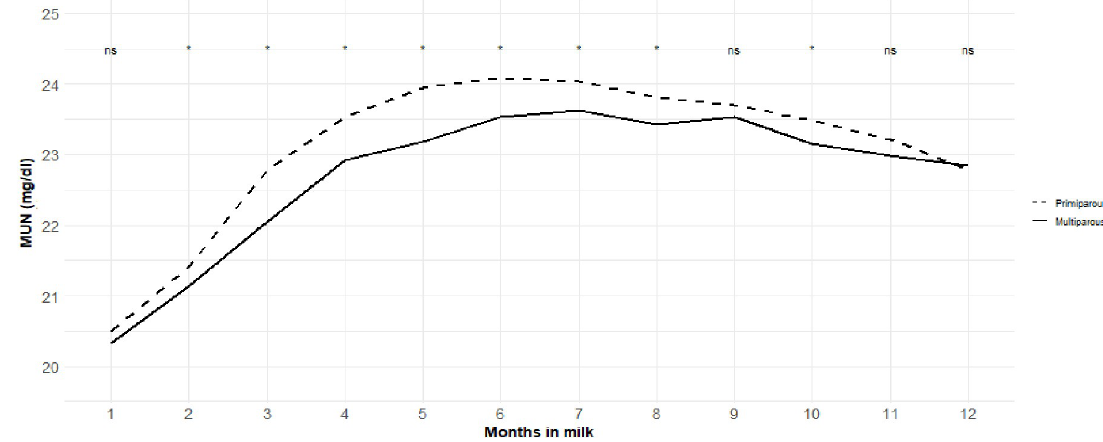
Fig 1. Trends (daily least square means) in concentrations of milk urea across lactation in primiparous and multiparous cows. https://doi.org/10.1371/journal.pone.0253191.g001 then increased by increasing DIM at the end of lactation where its highest level was found. Similar trends were found for permanent environmental and genetic variances. Mean additive genetic variance for MU in primiparous and multiparous cow was 7.02 and 7.07 (mg/dl) 2 , respectively. The corresponding values found for permanent environmental variance were 2.71 and 3.63 (mg/dl) 2 , respectively, in primiparous and multiparous cow. Additive genetic variance for MU was high in the beginning of lactation (7.05 and 6.24 (mg/dl) 2 , respectively, in primiparous and multiparous cows), reached the minimum level at DIM 57 (5.34 (mg/dl) 2 ) in primiparous and DIM 46 (5.30 (mg/dl) 2 ) in multiparous, then increased thereafter until the end of lactation where its maximum level was found (10.34 and 12.16 (mg/dl) 2 , respectively, at DIM 365 in primiparous and multiparous cows). Average heritability estimates for daily MU was 0.33 (SD = 0.02) ranged 0.29 to 0.36 and 0.32 (SD = 0.03) ranged 0.27 to 0.34, respectively, for primiparous and multiparous cows. Means and patterns of phenotypic, permanent envi- ronmental, and genetic correlations estimated on a daily basis between MU and production traits included are presented in Table 2 and Fig 3, respectively. Phenotypic correlations between MU and productive traits included were close to zero (ranged -0.04 to 0.04 and -0.03